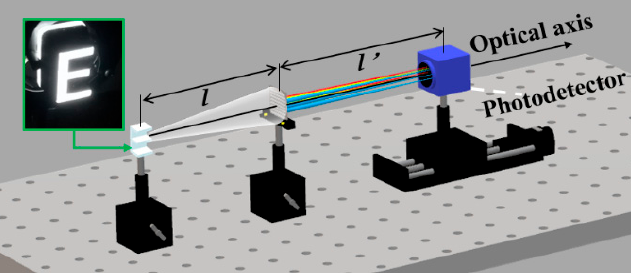
Figure 8. Multi-spectral imaging experimental verification.